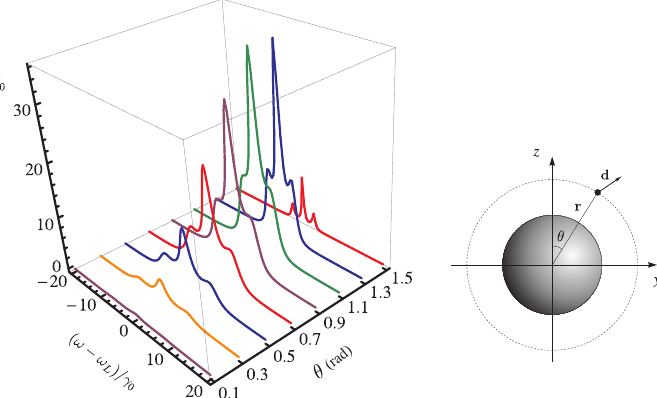
Figure 8. Resonance fluorescence spectra (normalized to I 0 ) of a two-level QE near a nanosphere with a radius of a = 20 nm in relation to the angle θ = 0.1–1.5 rad (5.7 ◦ to 85.9 ◦ ; the distance from the QE to the nanosphere surface is 10 nm, λ = 632.8 nm and γ 0 = 20 MHz, E 0 = 2000 V/m.